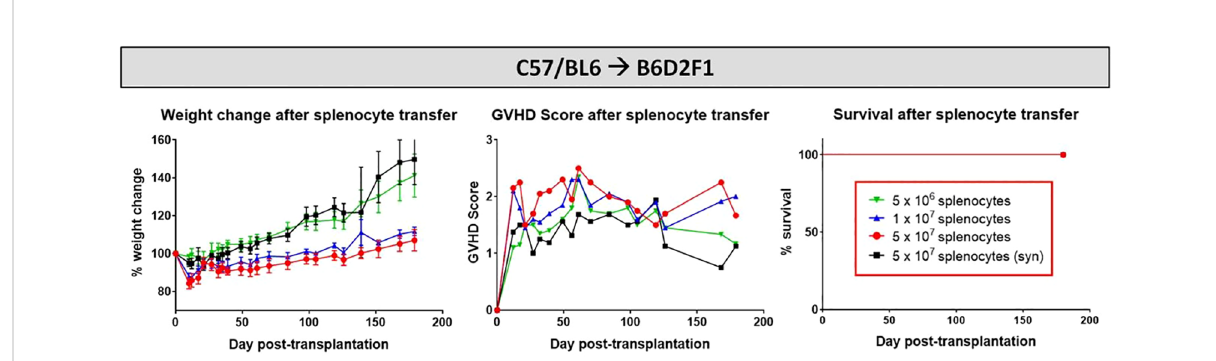
FIGURE 2 Cell dose titration for establishment of cGvHD in mouse models. C57BL/6 ➔ BDF1 model running for 180 days. Three different cell doses (1x106, 1x107 and 5x107) were transplanted in allo-setups and one as syn-control. Clinical GvHD was estimated by weight change (left), GvHD score (middle) and survival (right) Animals were regularly scored for fi ve clinical parameters (weight loss, posture, activity, fur and skin) on a scale from 0 to 2. Clinical GvHD score was summarized of all fi ve parameters. Error bars show mean ± SEM. n=5 per group.